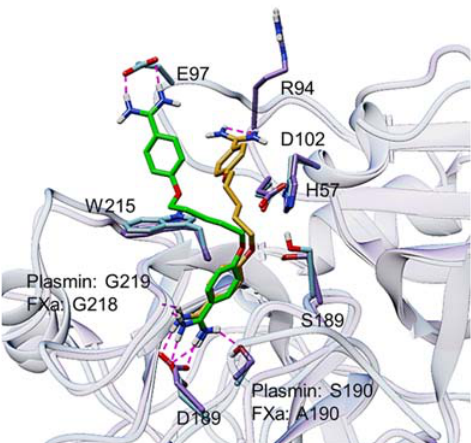
Figure 7. Glide ‐ based docking and scoring study of pentamidine binding to human FXa (PDB ID: 1FAX) (sky blue protein and green inhibitor) and plasmin (PDB ID:1BUI) (purple protein and gold inhibitor). The key interactions are shown as dash lines and pentamidine is shown as sticks. For the two proteins, one of the inhibitor’s protonated amidine groups is engaged with D189 residue.